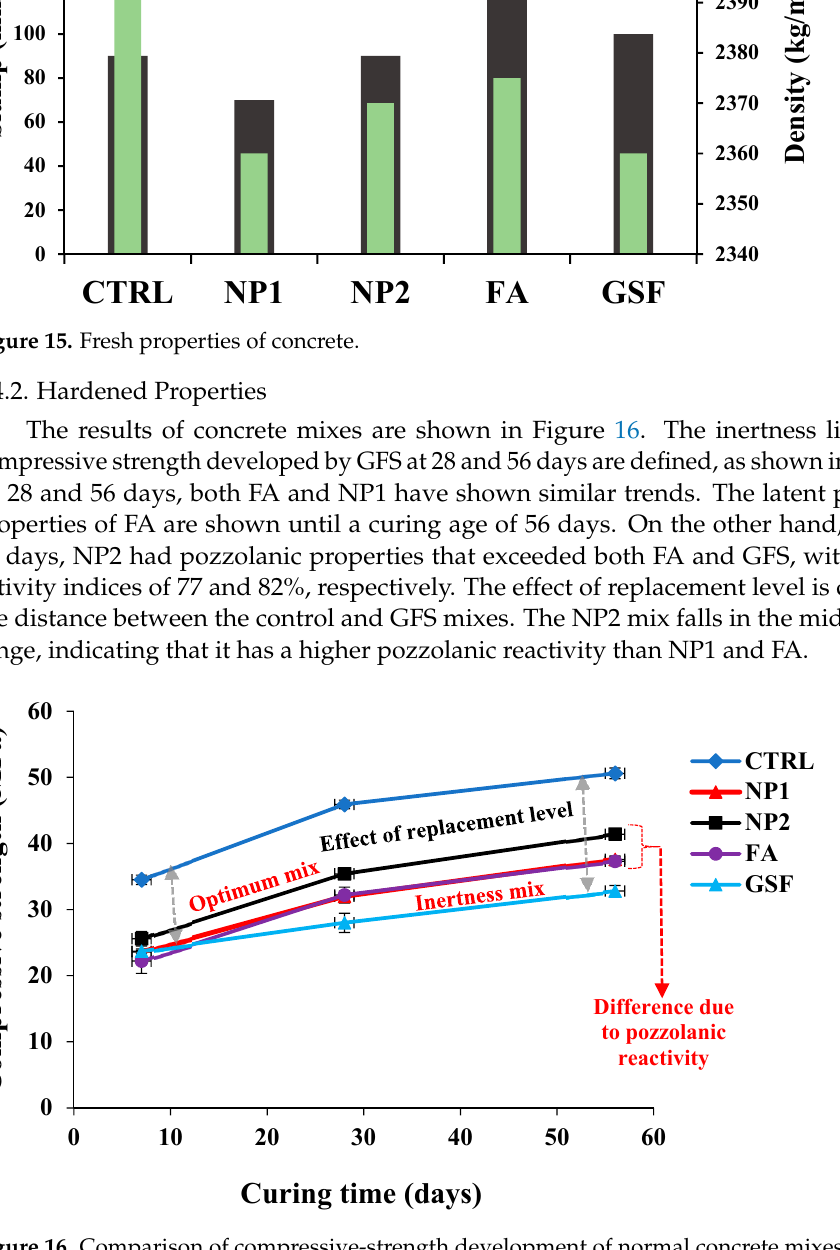
Figure 16. Comparison of compressive ‐ strength development of normal concrete mixes containing NP1, NP2, FA, and GSF.